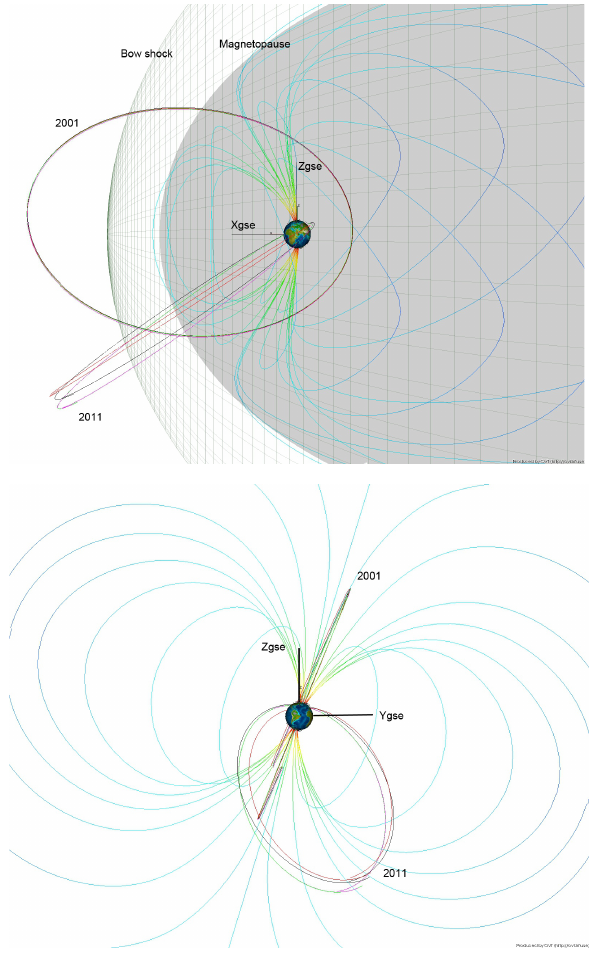
Figure 2. Cluster orbits during 2001 and 2011 in XZ GSE (top panel) and YZ GSE (bottom panel). 4 Fig. 2. Cluster orbits during 2001 and 2011 in XZ GSE (top panel) The blue field lines are from Tsyganenko 1996 (produced with Orbit Visualisation Tool). The 5 and YZ GSE (bottom panel). The blue lines represent field lines from Tsyganenko 1996 model (Tsyganenko, 1995) (produced with Orbit inclination, line of apsides and perigee altitude changed significantly from 2001 to 2011. 6 Visualisation Tool). The inclination, line of apsides and perigee al- titude changed significantly from 2001 to 2011.